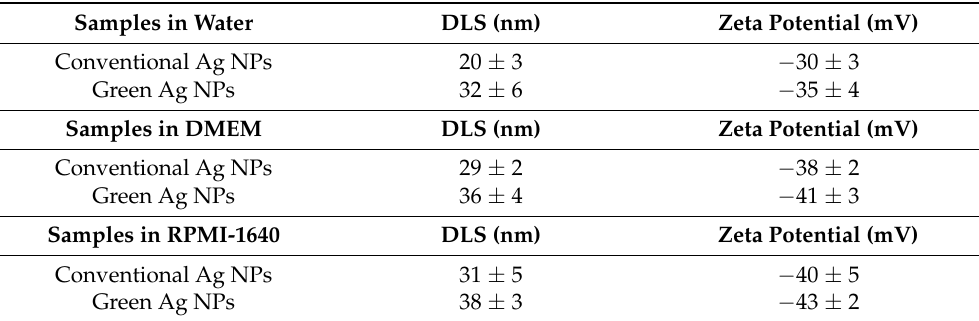
Table 1. Characterization of conventional and green Ag NPs in water, DMEM, and RPMI by DLS and ζ -potential